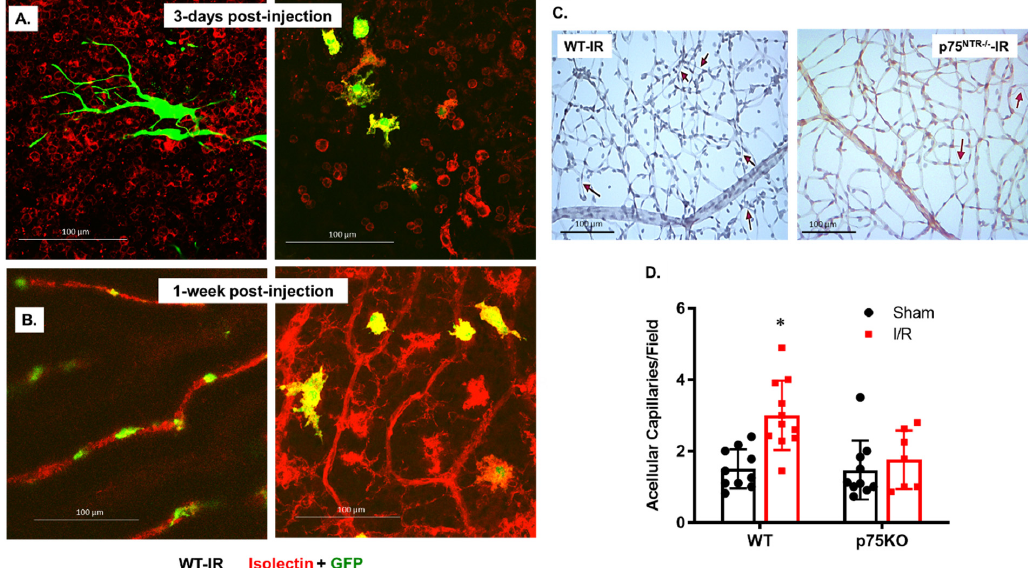
Figure 2. MSCs incorporate to ischemic retinal vasculature and decreased acellular capillaries in WT and p75 NTR-/- ischemic retinas. ( A , B ) Confocal images of retinal flat mounts stained with isolectin (red), showing incorporation of intravitreally-injected GFP-labeled MSCs (green) into WT retinas subjected to I/R (40x magnification). ( A ) Different regions of flat-mounted retina 3 days post injections showing some MSCs morphed into amoboid/satellite-like shape (green, left panel) and some MSCs picked up isolectin stain (yellow, right panel). ( B ) Different regions of flat-mounted retina 1 week post injection showing, in the left panel, that some of the MSCs appeared perivascular (green) wrapped around retinal capillaries (red) and some other MSCs (right panel) maintained satellite-like shape and co-stained with isolectin (yellow) within retinal capillaries (red), suggesting integration into retinal vasculature. ( C ) Representative trypsin-digested and PASH-stained retinas of WT and p75 NTR-/- mice subjected to I/R and receiving GFP-labeled MSCs. Bright field imaging showed decreased count for acellular capillaries (red arrows, 20x magnification). ( D ) Bar graph and statistical analysis for acellular capillaries count in WT and p75 NTR-/- retinas subjected to I/R and receiving GFP-labeled MSCs. Ischemic WT retinas still showed a significant increase in the count of acellular capillaries that was completely ameliorated in p75 NTR-/- retinas following MSCs injection (*, significant using two-way ANOVA, n = 7–11).